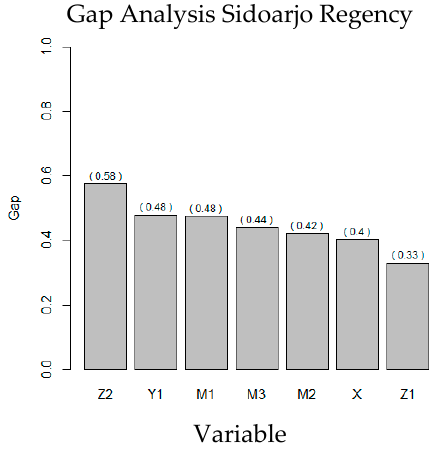
Figure A6. Bar Diagram of Gap Analysis of Sidoarjo Regency.